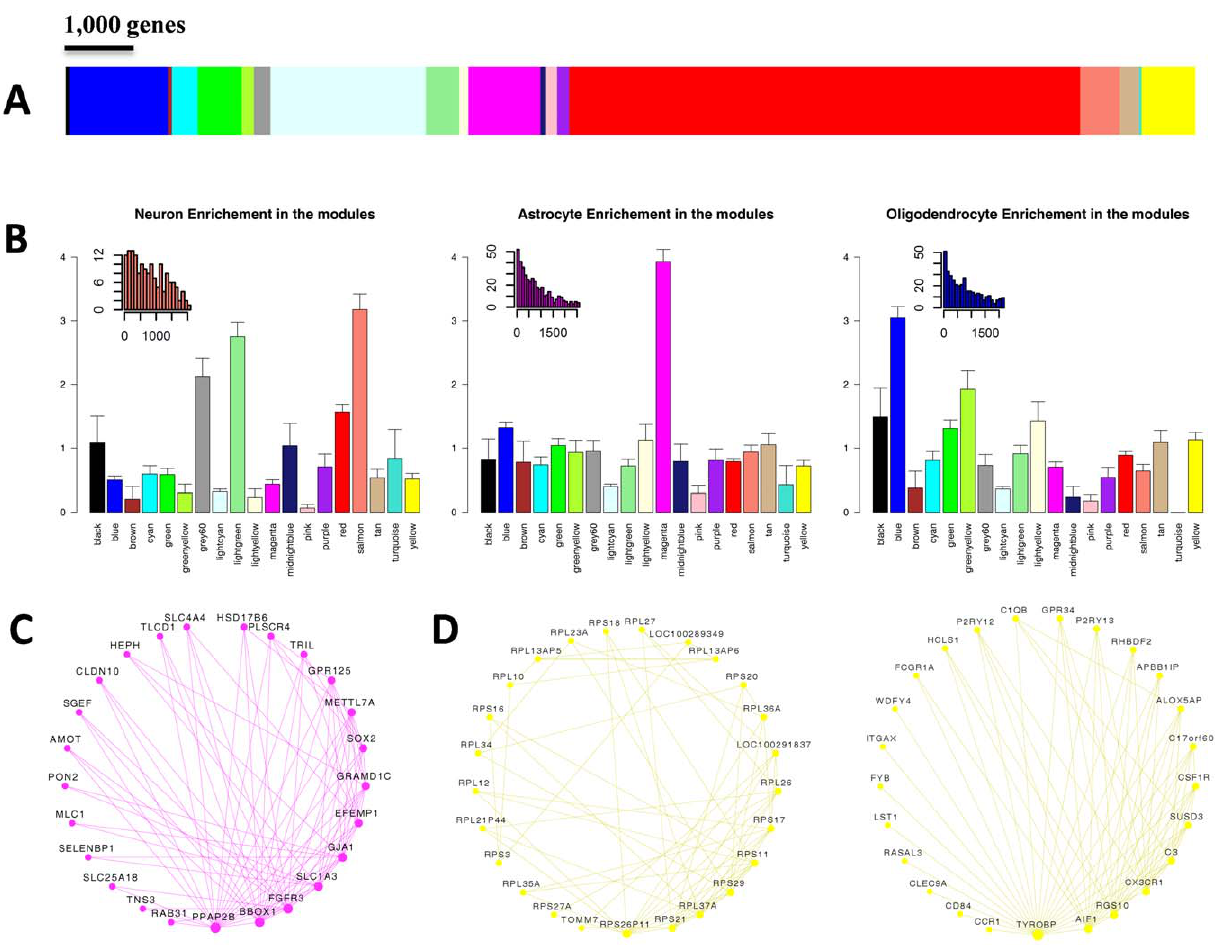
Figure 1. Weighted gene co-expression network analysis (WGCNA) of human brain transcriptomes. (A) Color map showing the relative sizes of the different modules in the WGCNA analysis. Colors correspond to arbitrary names given to each module. (B) Enrichment for genes up- regulated in Neurons (left), Astrocytes (center) and Oligodendrocytes (right). For each module, the relative risk (RR) for harboring cell-type specific genes is plotted. Insets show the distribution of the rank of enriched genes located in modules with the highest cell-type specific RR. The distribution is shown for the Salmon, Magenta and Blue module for genes enriched in neurons, astrocytes, and oligodendrocytes (respectively). (C) Top connected genes in the Magenta module. Nodes are ordered and sized according to their degree. (D) Top connected genes in the Yellow module, revealing two distinct groups of genes. One group (left circle) includes genes involved in protein translation, and the other (right circle) includes Microglia specific